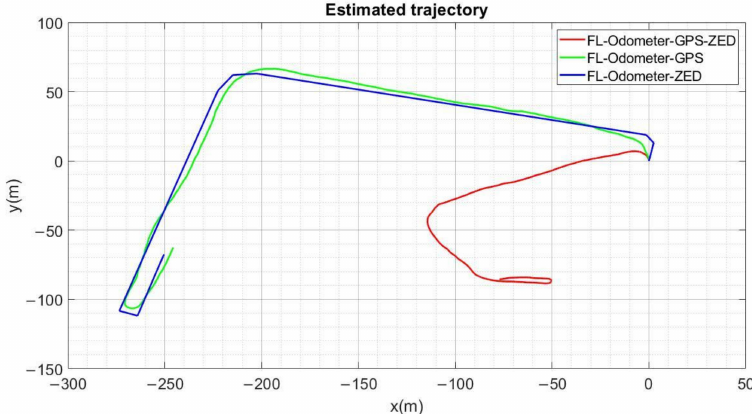
Figure 4. Measurements of the sensors through the route traveled.